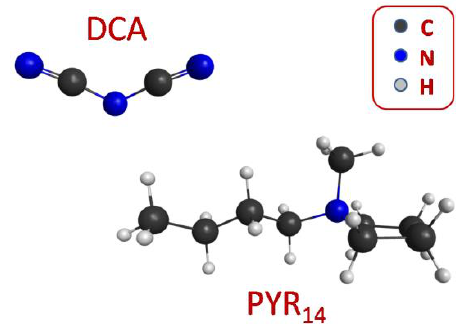
Figure 1. Basic structure of the PYR 14 cation and the DCA anion.